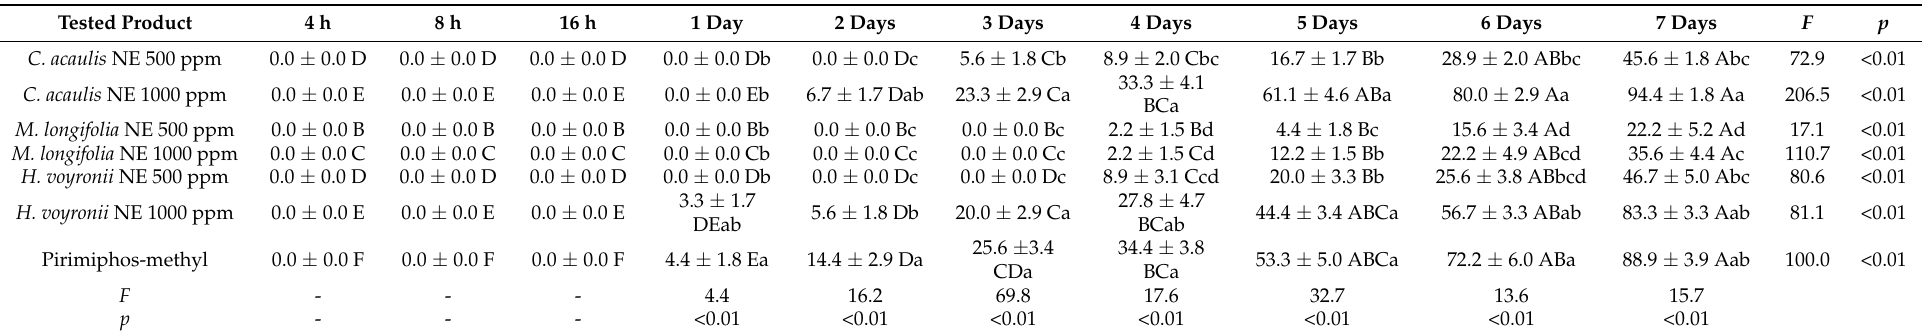
Within each row, means followed by the same uppercase letter are not significantly different (DF = 9, 89; Tukey’s HSD test at p = 0.05). Within each column, means followed by the same lowercase letter are not significantly different (DF = 6, 62; Tukey’s HSD test at p = 0.05). Where dashes exist, no analysis was conducted. Table 3. Mean (%) mortality ± standard error (SE) of Sitophilus oryzae adults after 4 h, 8 h, 16 h, 1 day, 2 days, 3 days, 4 days, 5 days, 6 days, and 7 days in oats treated with 6% ( w / w ) Carlina acaulis , 10% ( w / w ) Mentha longifolia, and 6% ( w / w ) Hazomalania voyronii essential oil-based nanoemulsions at two different concentrations. Pirimiphos-methyl was the positive